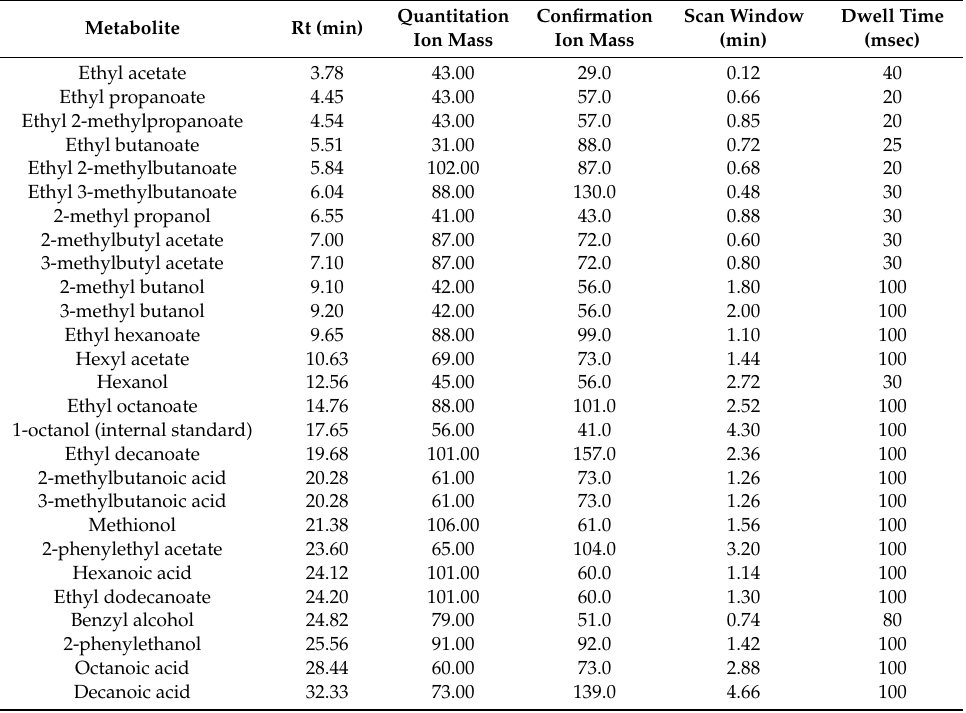
Table A1. List of yeast-derived volatile secondary metabolites as analyzed by HS-SPME GC-MS. Metabolite Rt (min)